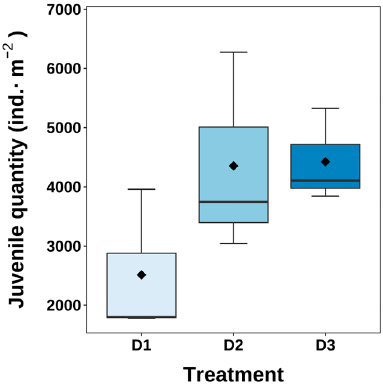
Figure 7. Number of juvenile (ind.·m − 2 ) ovigerous P. clarkii in the three different treatments after 55 days. The diamond symbol inside the box represents the mean. Table 2. The economic benefits (gross profit and BCR; mean ± SE) of breeding P. clarkii at different shelter